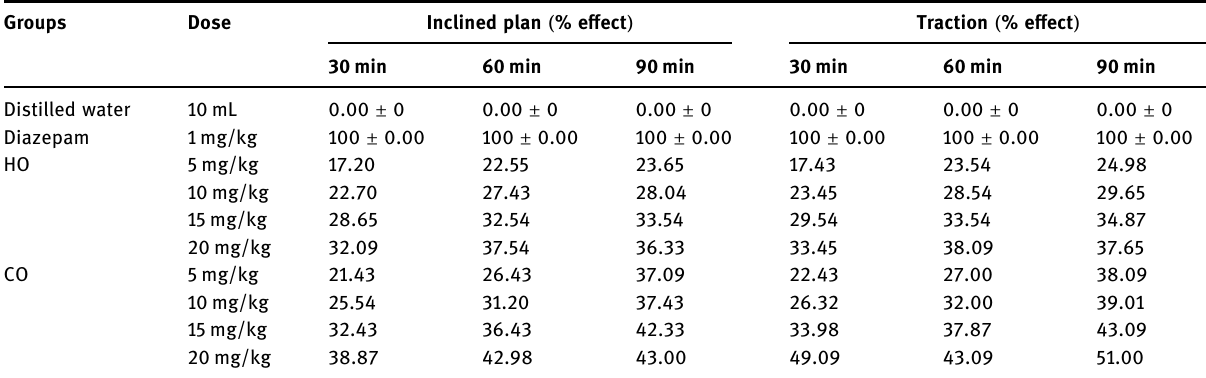
Table 7: Muscle relaxant e ff ect of oil extracts from HO and CO fractions of F. benghalensis